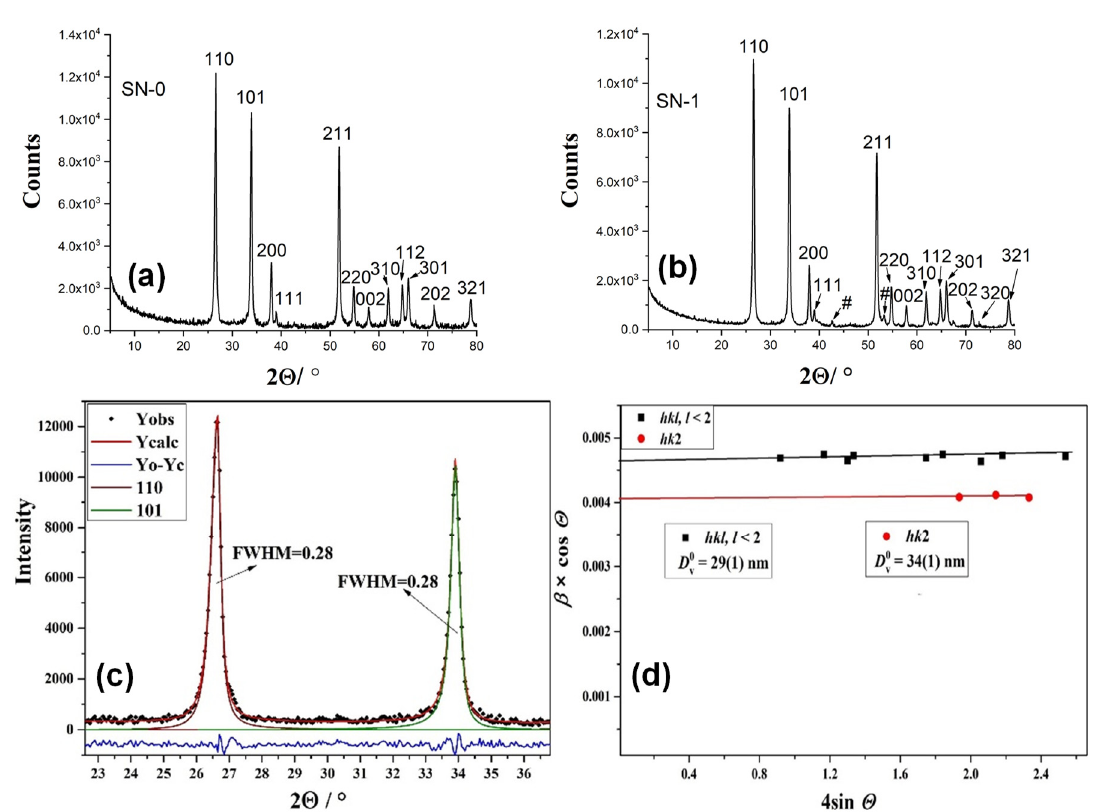
Figure 1. ( a ) XRD patterns of samples SN-0; ( b ) XRD patterns of samples SN-1. Both samples are assigned according to ICDD card 41-1445 (cassiterite). The hkl indices of cassiterite are indicated. # indicates unidentified maxima; ( c ) the results of individual profile fitting of cassiterite diffraction lines 110 and 101 in sample SN-0; ( d ) Williamson–Hall analysis of cassiterite in sample SN-0. The value of the volume-averaged domain size ( D 0 v ) was determined from the y -axis intercept and the value of the upper limit of microstrains ( e ), from the slope of the line.